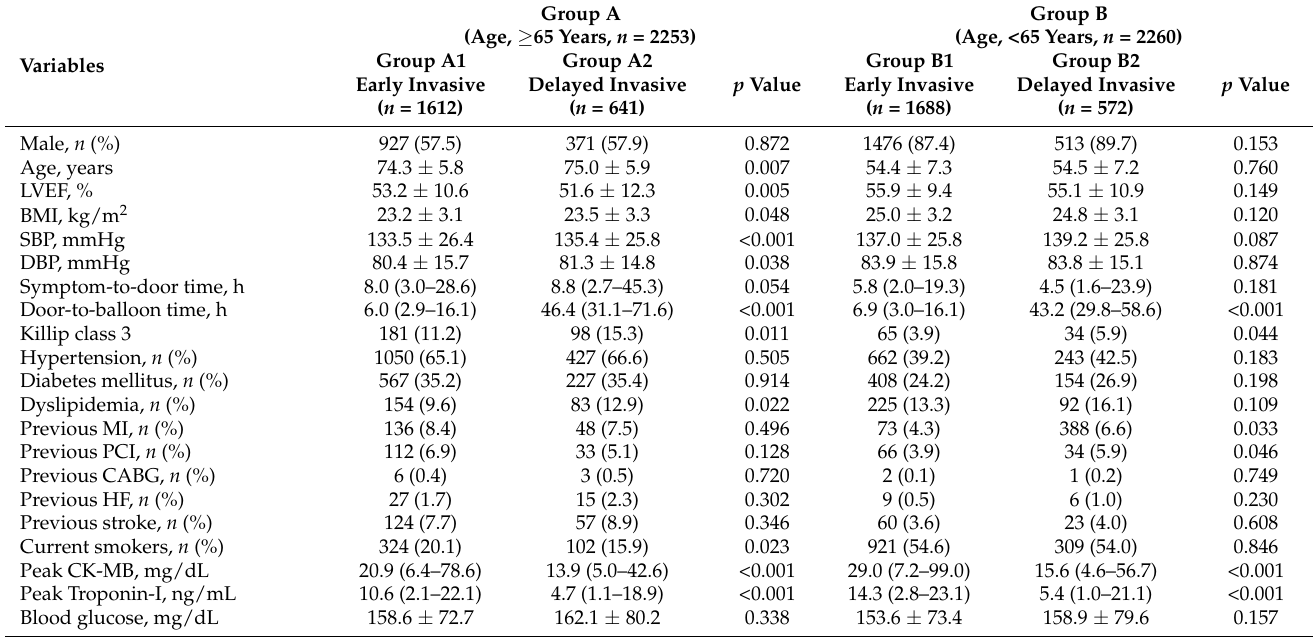
Figure 1. Flowchart. PCI, percutaneous coronary intervention; POBA, plain old balloon angioplasty; BMS, bare-metal stent; DES, drug-eluting stent; CABG, coronary artery bypass graft; STEMI, ST- segment-elevation myocardial infarction; NSTEMI, non-STEMI; EI, early invasive; DI, delayed invasive. Table 1. Baseline characteristics and discharge medications.